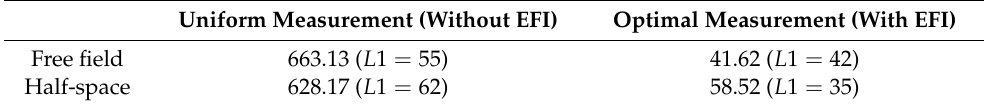
Table 6. Different values of γ in CMESM with 90 measurement points.